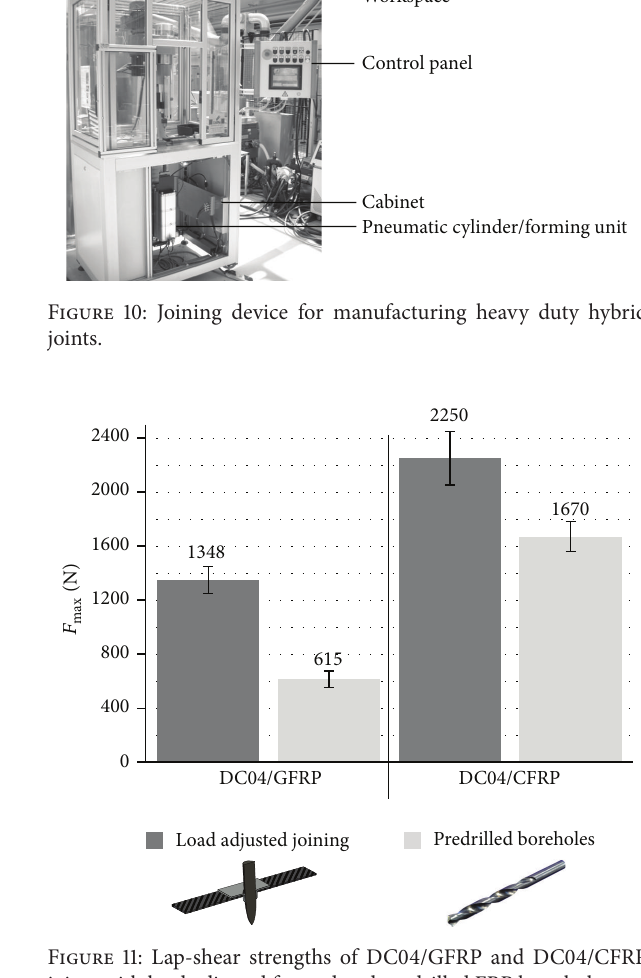
Figure 9: Joining device for themanufacturing of heavy duty hybrid joints: (a) basic components, (b) flow drill unit, (c) forming unit, and (d) fixing unit. (1) Hot air heating system with ring nozzle, (2) forming tool, (3) force transducer, (4) pneumatic cylinder for forming closing head, (5) drilling unit, (6) flow drill tool, (7) pneumatic cylinder/abutment, (8) abutment plate, (9) fixing plate, (10) pneumatic cylinder/fixing plate, (11) cavity with nozzle output, and (12) machine table.